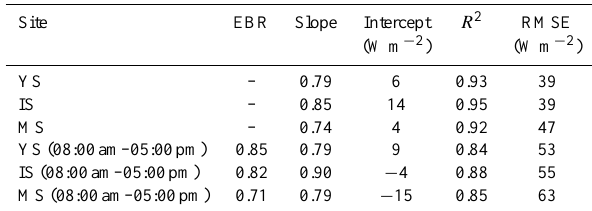
Table A1. Parameters of the linear regression between the